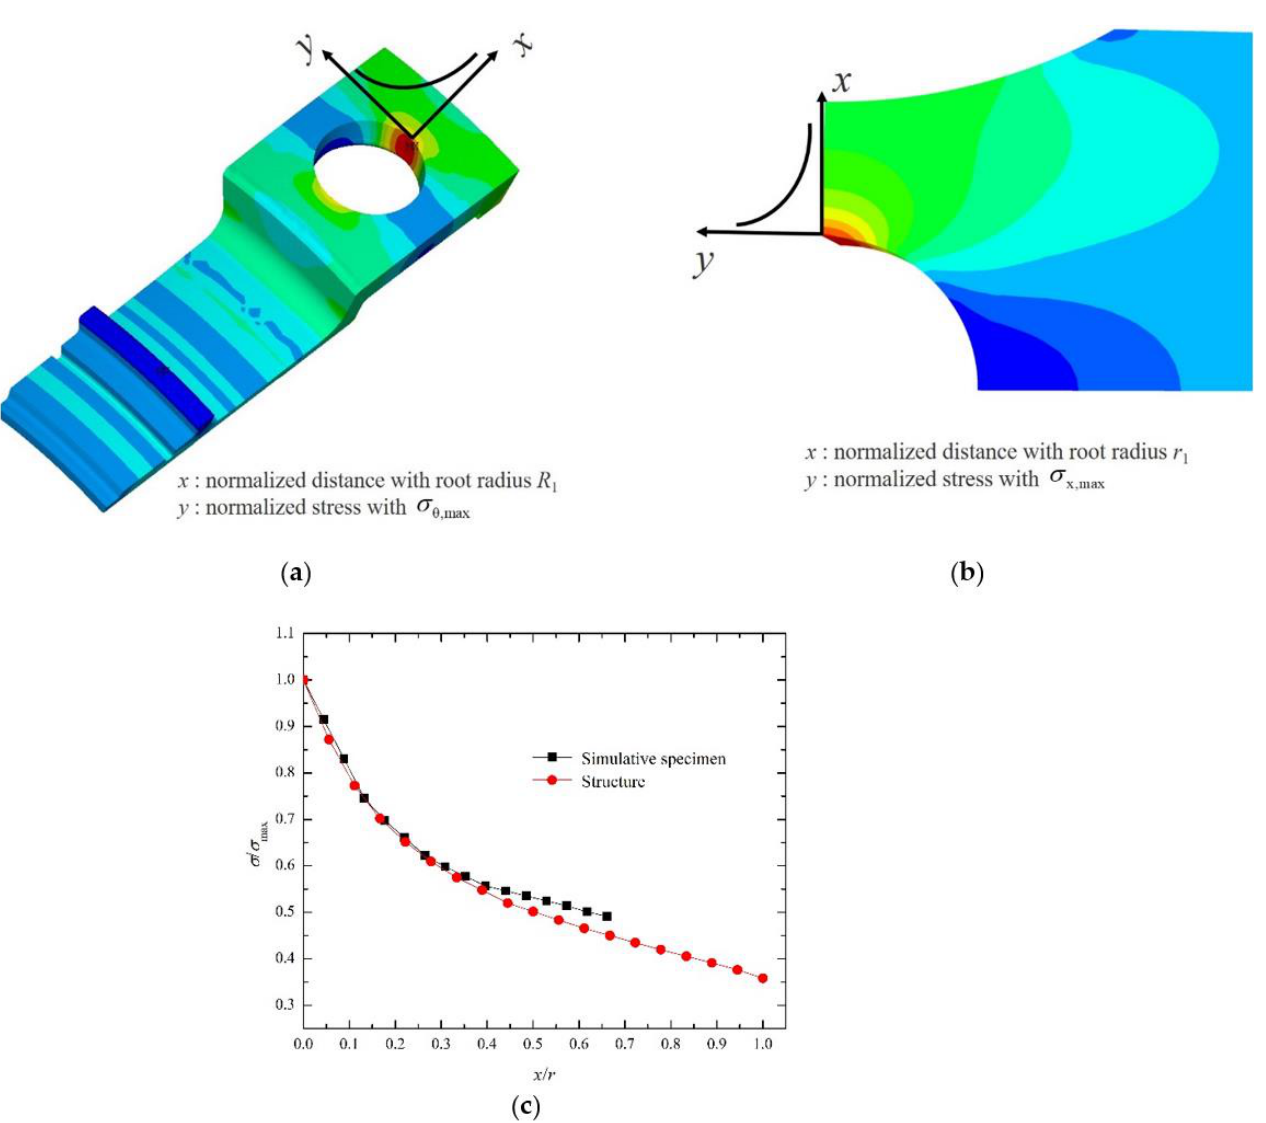
Figure 17. Comparison of stress gradient between the structure and the simulative specimen: ( a ) path of stress gradient extracted from the structure; ( b ) path of stress gradient extracted from the simulative specimen; ( c ) results of the normalized stress gradient.